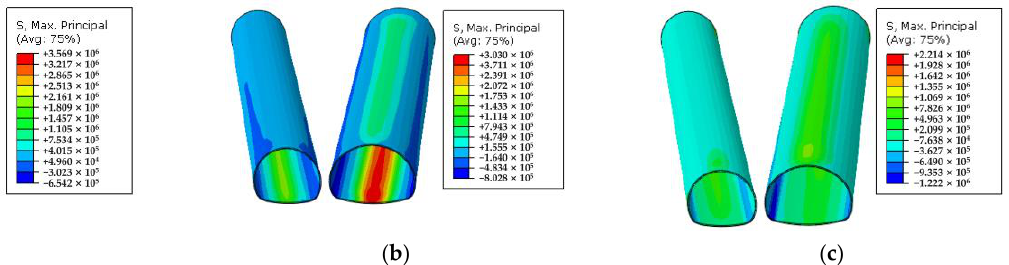
Figure 15. Maximum principal stress distribution of main line tunnel and ramp support structures: ( a ) Grade III rock mass; ( b ) Grade Ⅳ rock mass; ( c ) Grade Ⅴ rock